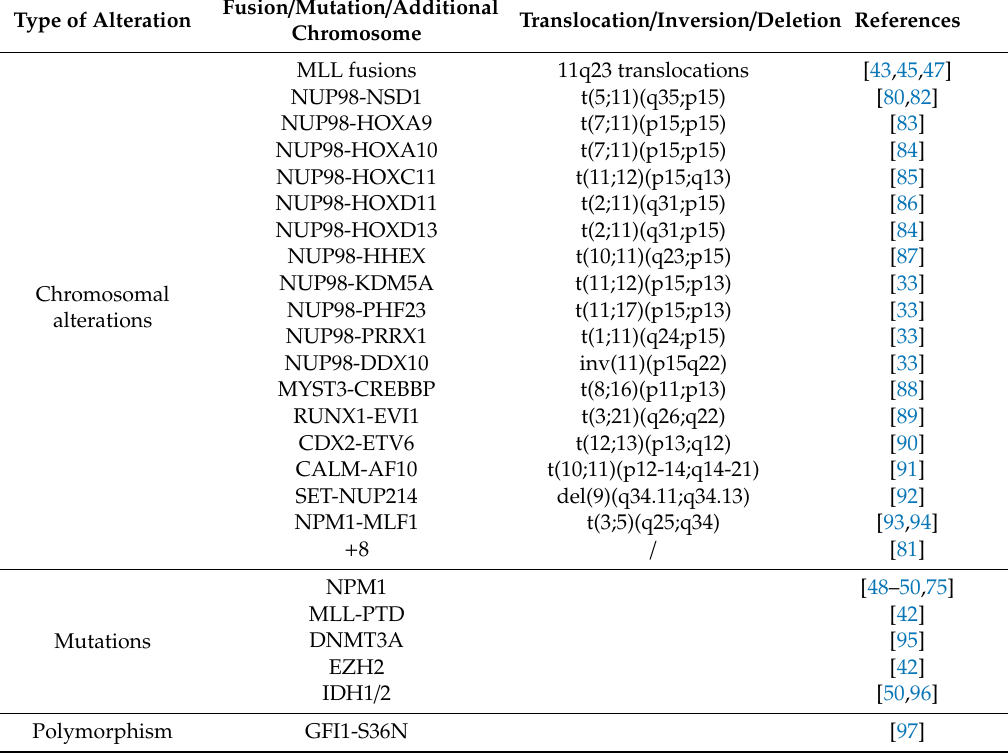
Table 1. List of the main genetic alterations in AML that are associated with HOXA9 over-expression. Type of